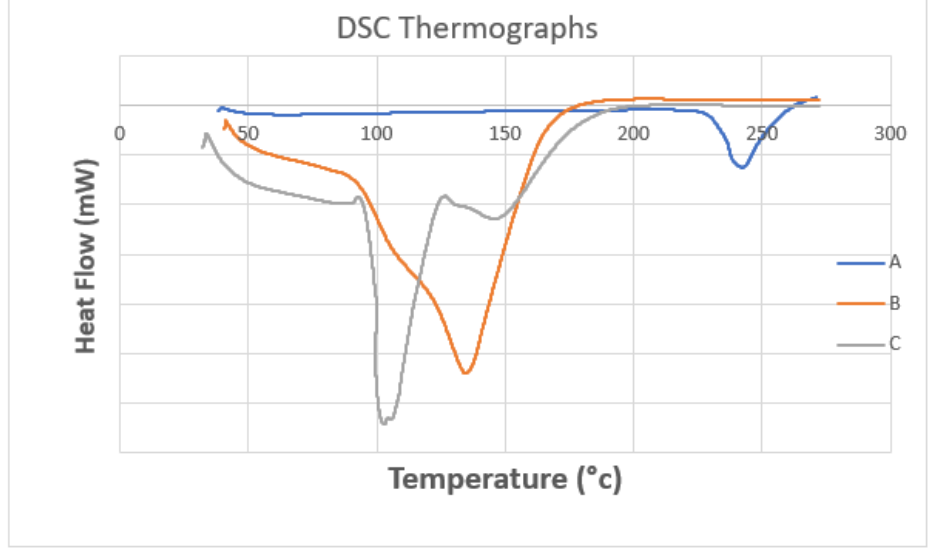
Figure 6. DSC thermograms of ( A ) pure metformin, ( B ) the optimal metformin-loaded ethosome formula and ( C ) an empty formula (excipient).